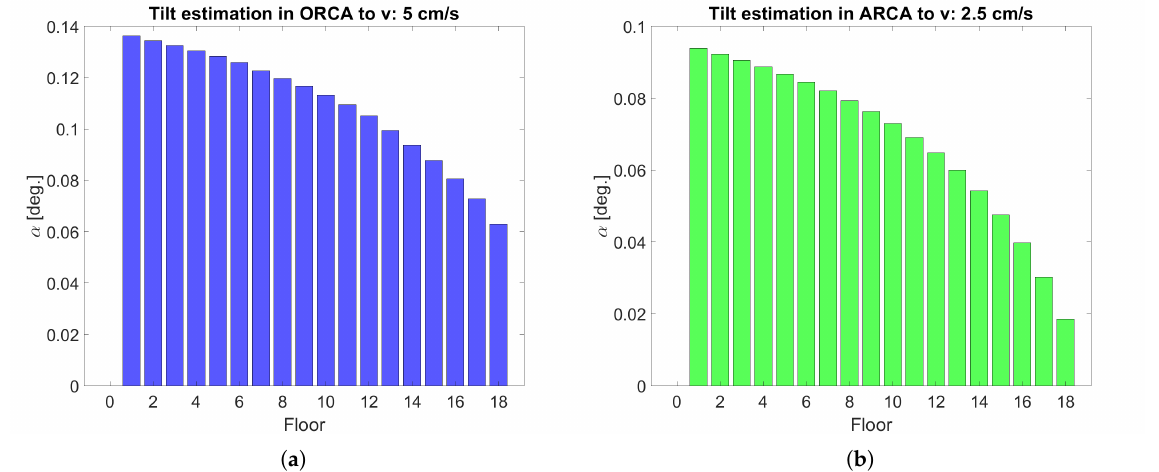
Figure 6. Tilt value from MM application for the DOMs in a DU (labeled Floor, with Floor 1 the lowest DOM in the DU) using representative sea current values in ORCA and ARCA. ( a ) Tilt in ORCA for a typical sea current of 5 cm/s. ( b ) Tilt in ARCA for a typical sea current of 2.5